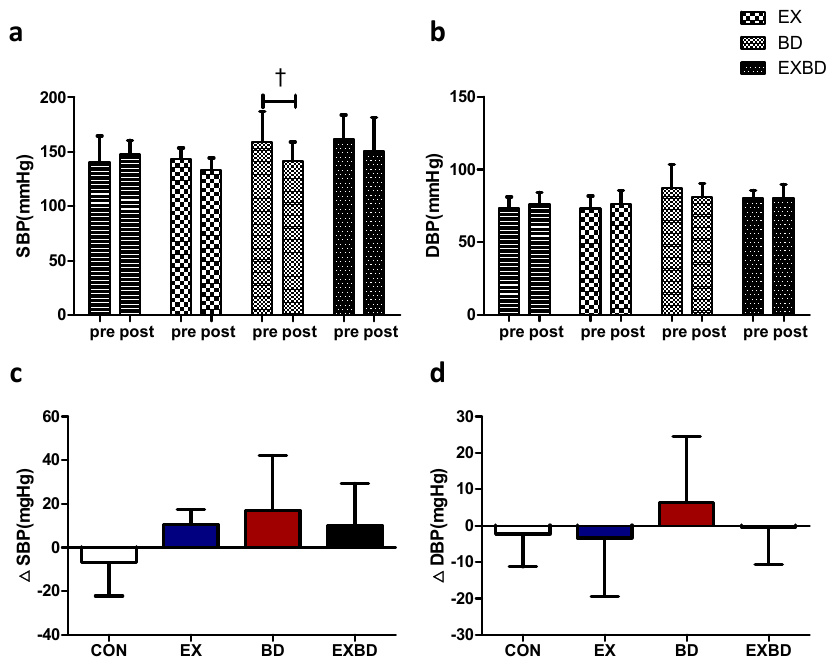
Figure 2. Effect of 16 weeks of aquatic aqua exercise and burdock intake on the blood pressure in older women with metabolic syndrome. ( a ) The systolic blood pressure in the BD group decreased after the 16-week intervention compared with the baseline values. ( b ) No significant changes were detected in the diastolic blood pressure in all groups. Furthermore, no significant differences in systolic ( c ) or diastolic ( d ) blood pressure variation were observed among the groups using one-way analysis of variance. Data are presented as the mean ± standard variation. † p < 0.05, significant; before vs. after intervention. SBP, systolic blood pressure; DBP, diastolic blood pressure; CON, placebo control, EX, exercise + placebo, BD, burdock, EXBD, exercise +